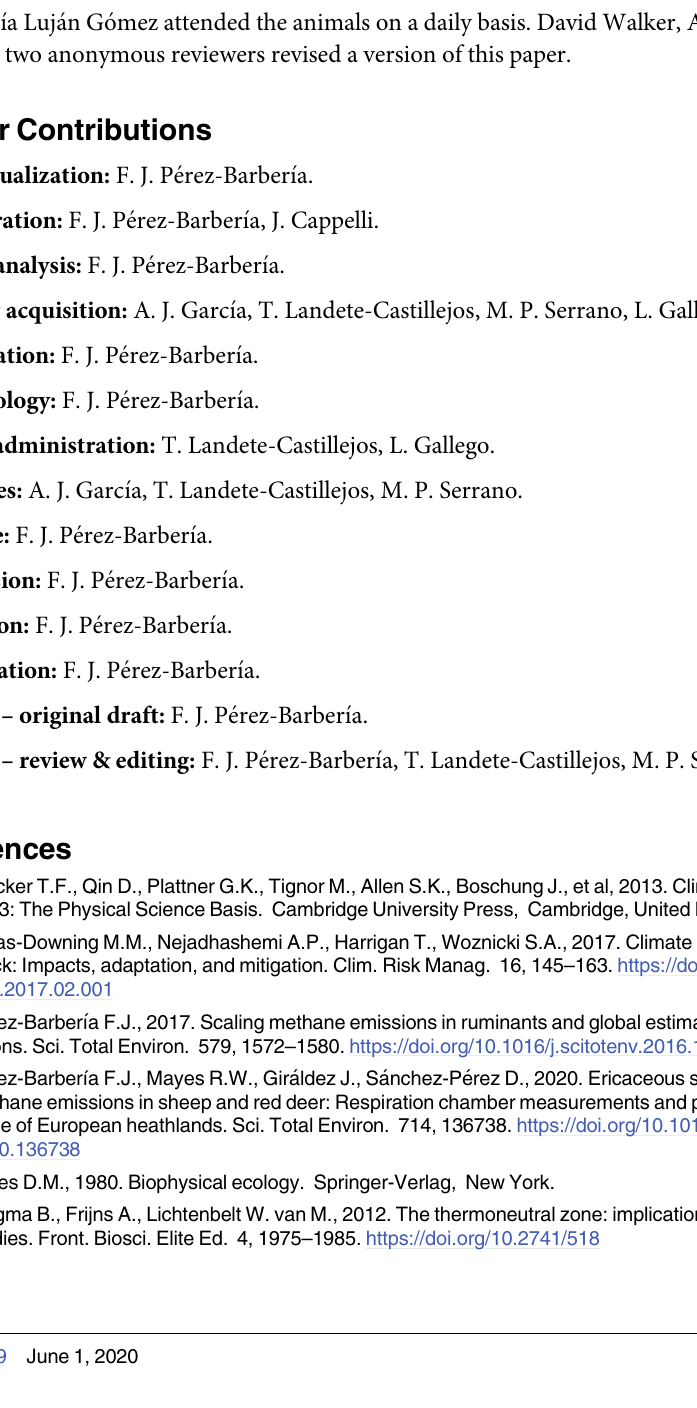
S4 Fig. Supplementary material. Response of mother body weight through lactation (from birth to forced weaning day 143) to mother age (years) and calf age (days) of the final model in Table 5, all other variables in the model fixed at their mean values. Dashed line: ± standard error. Response variable has been centred by subtraction of the mean value.